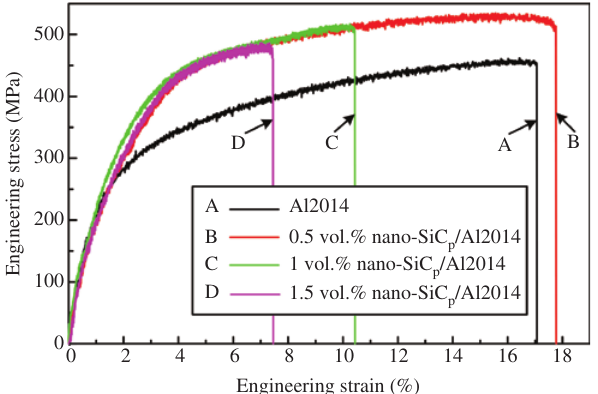
Figure 7: The tensile engineering stress-strain curves of the extruded Al2014 and nano-SiC /Al2014 composites reinforced by p different contents of SiC particles.